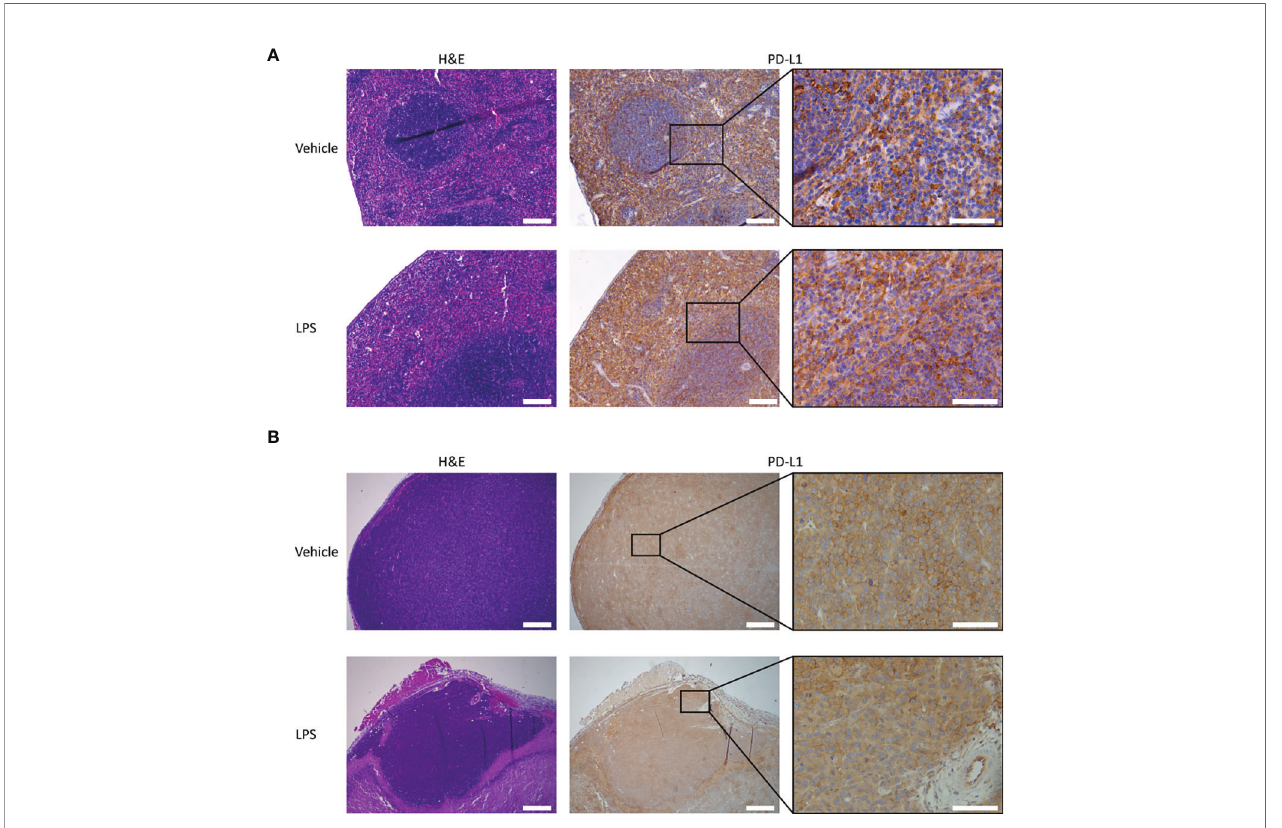
FIGURE 4 | PD-L1 expression and H&E staining of tumor and splenic tissues of LPS- and vehicle-treated mice. Representative images of the immunohistochemical analysis of PD-L1 expression in tumor and spleen tissue of RenCa tumor-bearing BALB/c mice, 2 days after LPS stimulation and vehicle control injection. (A) Splenic PD-L1 expression is very high for both vehicle control- and LPS-treated animals. LPS stimulation appears to slightly increase PD-L1 expression in the red pulp. (B) Tumor PD-L1 expression is not signi fi cantly altered by immune stimulation with LPS. The scale bar represents 500 µm or 100 µm in inset. LPS,